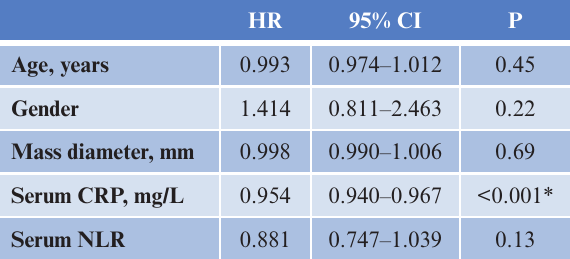
Table 5: Univariate Cox Proportional Hazard Regression Analysis of the parameters age, gender, mass diameter, and serum CRP and NLR levels for prediction of malignant pathology after renal mass biopsy.